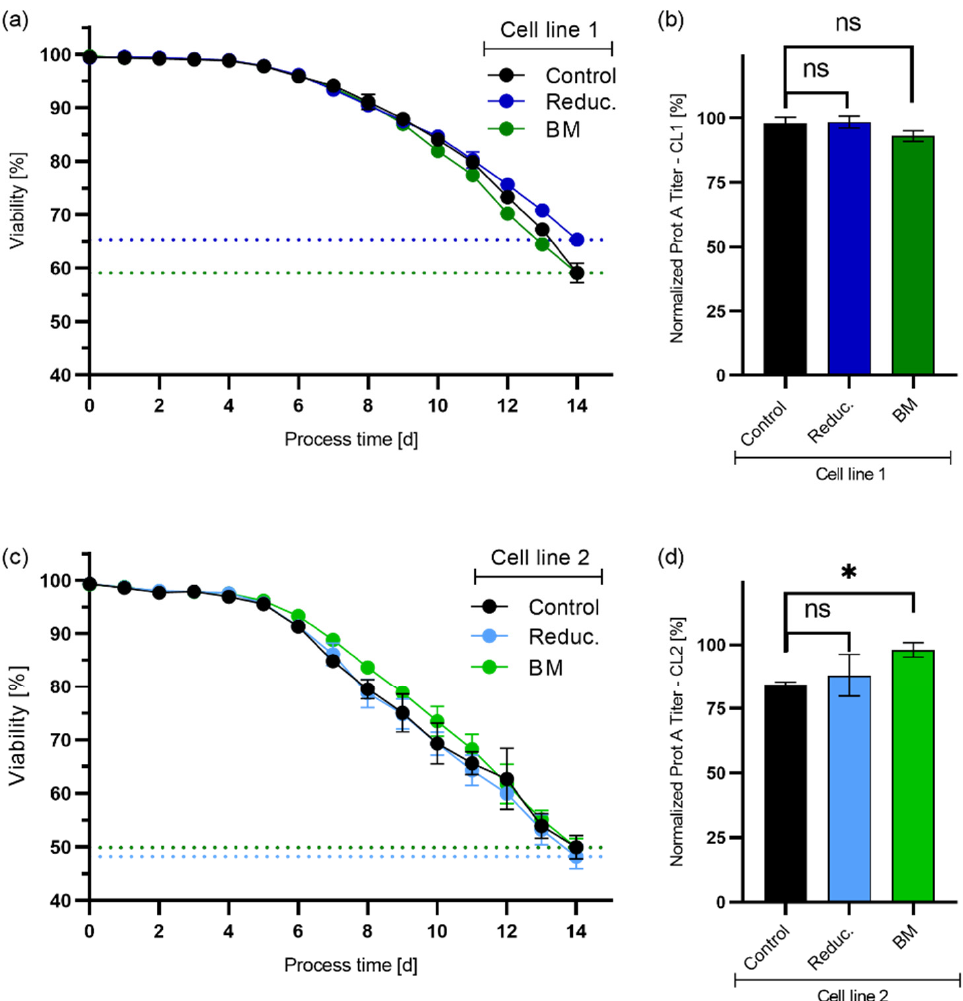
Figure 9. ( a , c ) Viability and ( b , d ) pre-harvest titer (normalized) for the cell line 1 ( a , b ) and cell line 2 ( c , d ) with the comparison of three processes: the HSCD10M control process (black), the HSD10M process with an earlier reduction in the feeding rate (denoted Reduc. in blue) and the HSD10M process with addition of bolus media (on process day 0–5) with the amino acids asaparagine, aspartate, glutamate and isoleucine (denoted BM in green). The processes were performed in duplicate ( n = 2). An unpaired t -test was performed for the Prot A titer at harvest. n.s. means not significant, * means p ≤